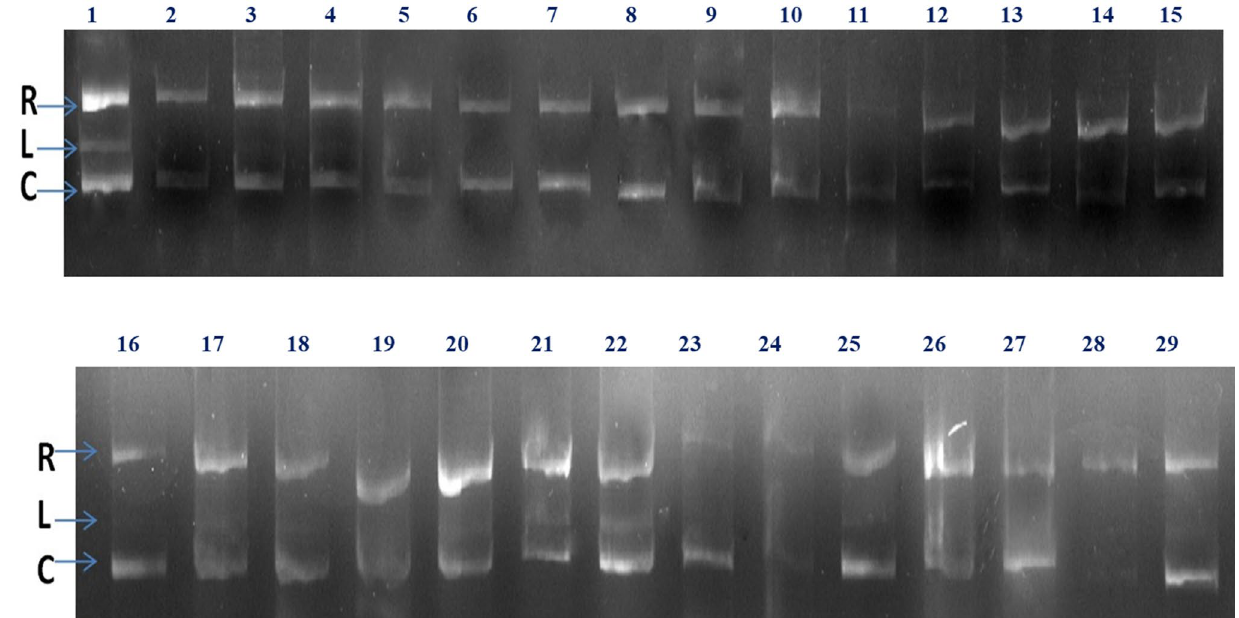
Figure 1. Showing comparative electrophoretic pattern of pBR322 DNA nicking inhibition activity of solvent extracts of T. arjuna. Here, 1–29 is representating lanes: 1—Plasmid DNA; 2—H 2 O 2 + Plasmid DNA; 3—THF + Plasmid DNA; 4—THF + H 2 O 2 + Plasmid DNA; 5—BHA + H 2 O 2 + Plasmid DNA; 6— BHT + H 2 O 2 + Plasmid DNA; 7—Ascorbic acid + H 2 O 2 + Plasmid DNA; 8—Gallic acid + H 2 O 2 + Plasmid DNA; 9—Hex-AB